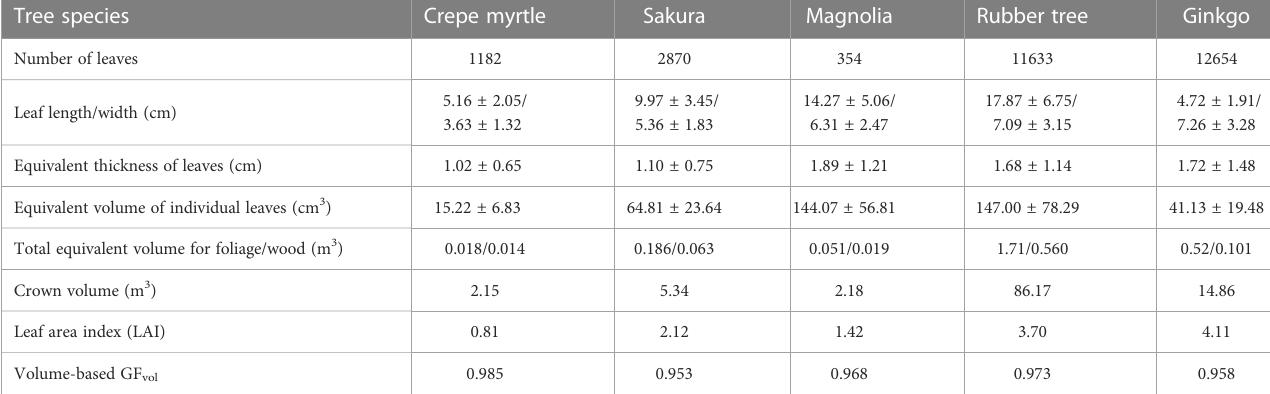
TABLE 2 The inversion results for the volume-based canopy gap fraction and related branch and leaf parameters for the fi ve experimental tree species. Tree species Crepe myrtle Sakura Magnolia Rubber tree Ginkgo